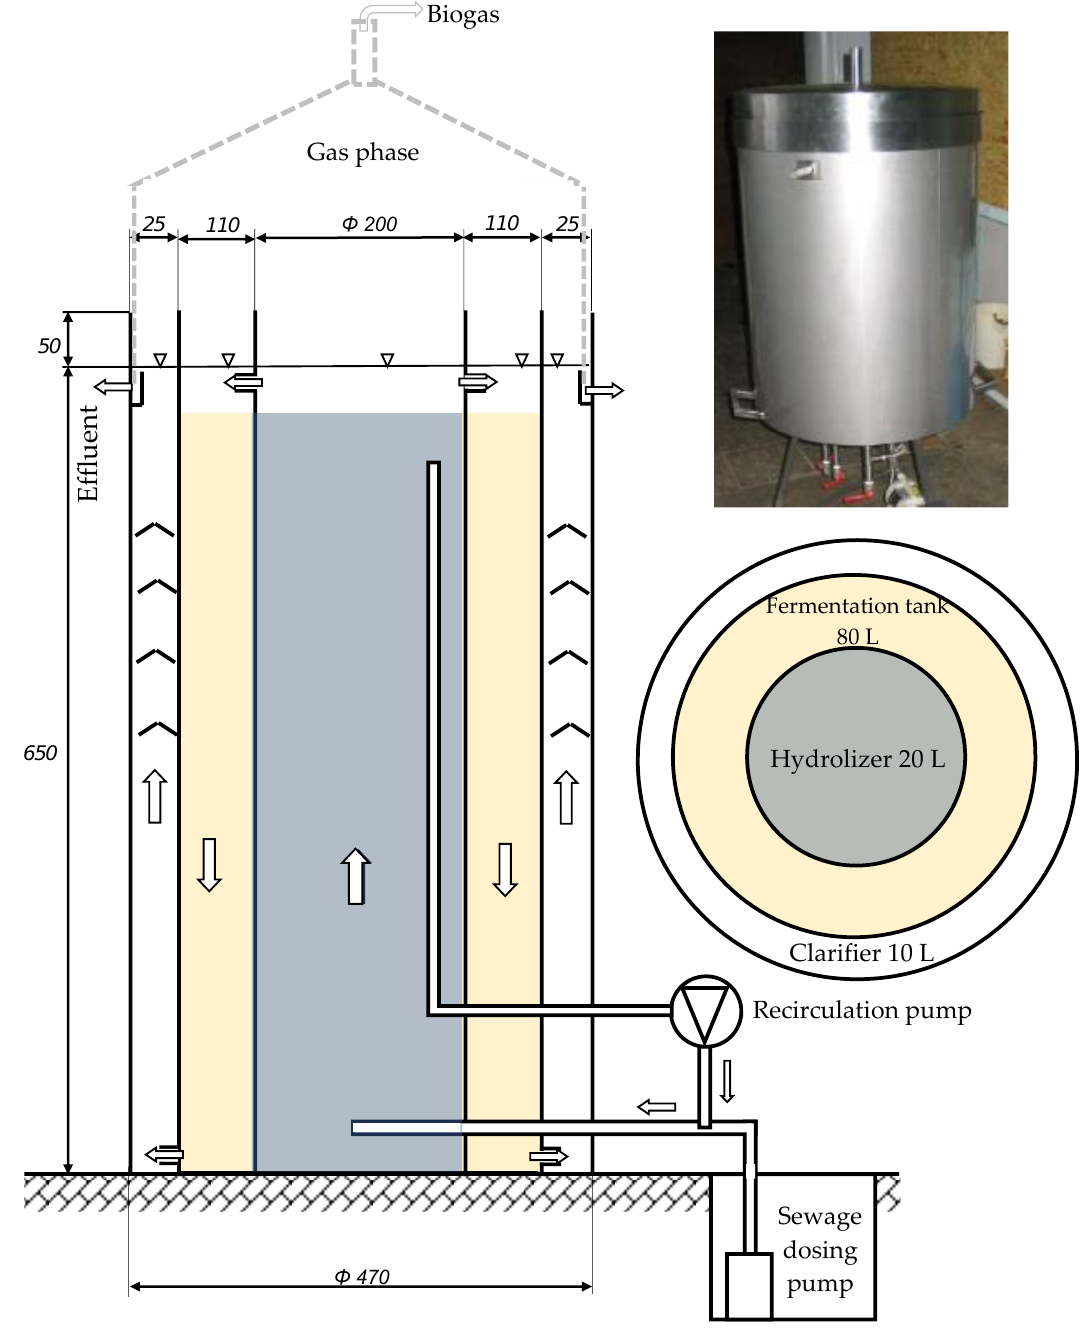
Figure 3. The AL-FB with vertical wastewater flows exploited on a semi-technical scale. Wastewater flowed from the bottom of the reactor to the central part of the